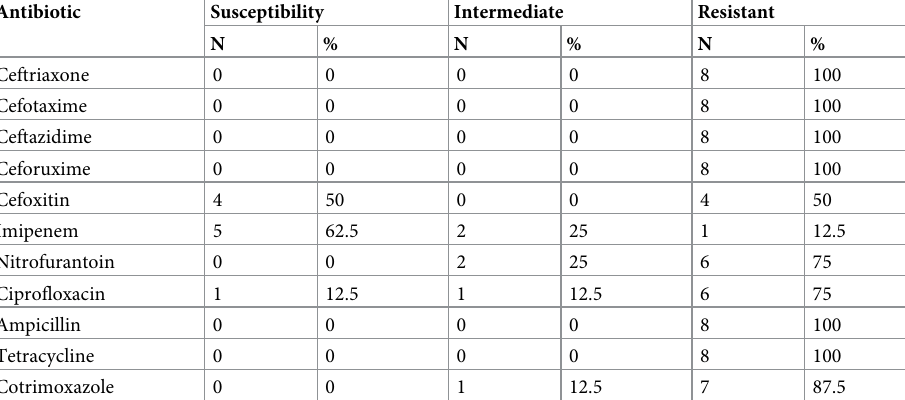
Table 6. Antibiotic resistant pattern of E . coli producing ESBLs among food handlers.